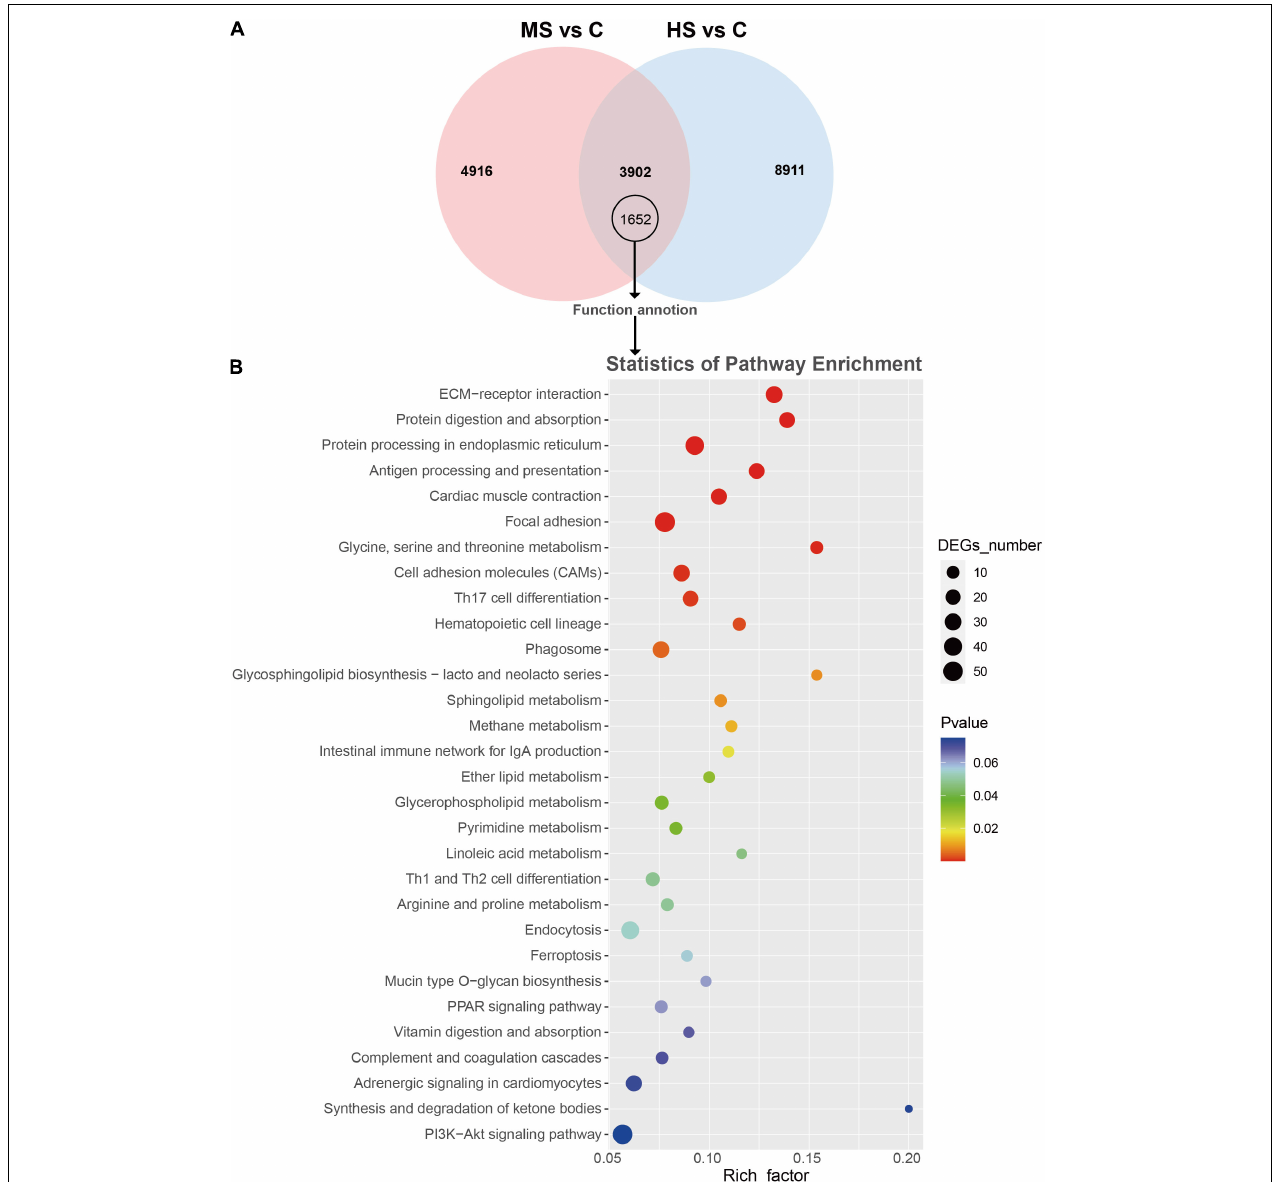
FIGURE 1 | Venn diagram, KEGG enrichment analysis of the shared DEGs in MS vs. C and HS vs. C groups. (A) Venn diagram showed the 8,818 in MS vs. C group and 12,813 DEGs in HS vs. C group, and 1,652 shared annotated DEGs. (B) Scatter diagram of KEGG enrichment analysis of the shared DEGs. X -axis (enrichment factor) indicates the enrichment level of DEGs in each pathway, while Y -axis represents the reliability of enrichment analysis of each